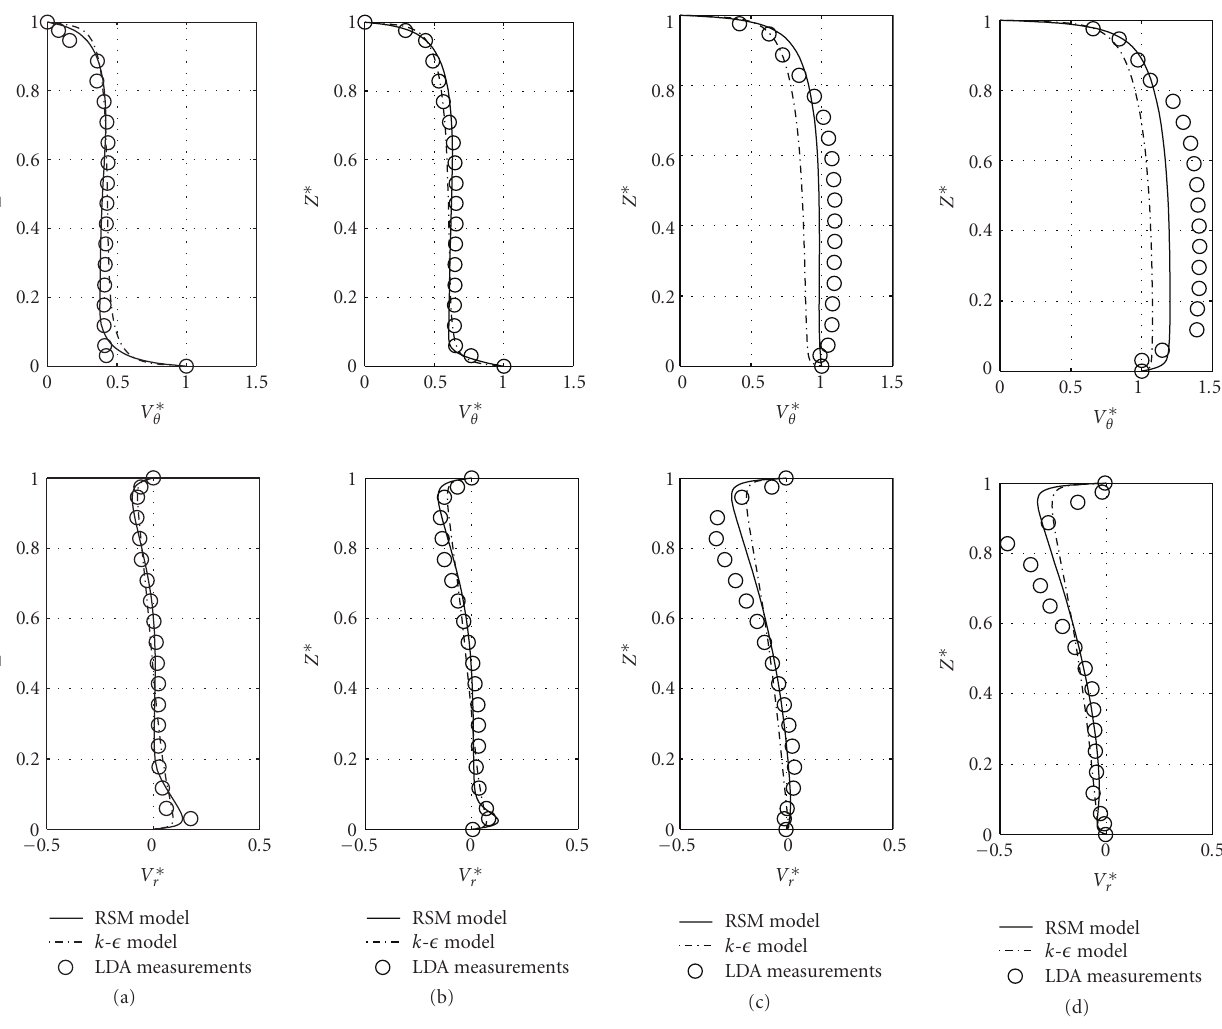
Figure 3: Axial profiles of two mean velocity components at r ∗ = 0 . 56 for G = 0 . 036 and Re = 10 6 with or without a centripetal superimposed throughflow: (a) C w = 0, (b) C w = 1976, (c) C w = 5929, (d) C w = 9881. Comparisons between the present RSM model ( − ), the k - (cid:2) model ( −·− ), and LDA measurements ( ◦